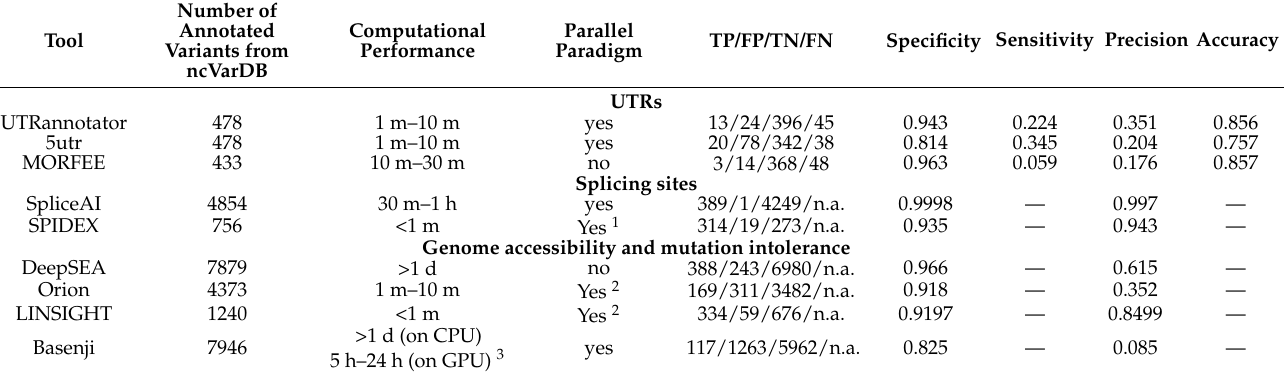
Figure 1. Graph of the approach followed in defining, grouping, and analyzing selected tools. A first literature screening was performed to retrieve the most promising existing methods for NCVs analysis. They belong to ‘Annotators’, ‘Integrators’, or ‘Investigators’ groups. Focusing on components of the ‘Investigators’ group, inclusion criteria were applied to select a set of best-hits. They were clustered relying on the genomic region they targeted, and several features were critically evaluated. Table 3. Performance for each selected tool, grouped by